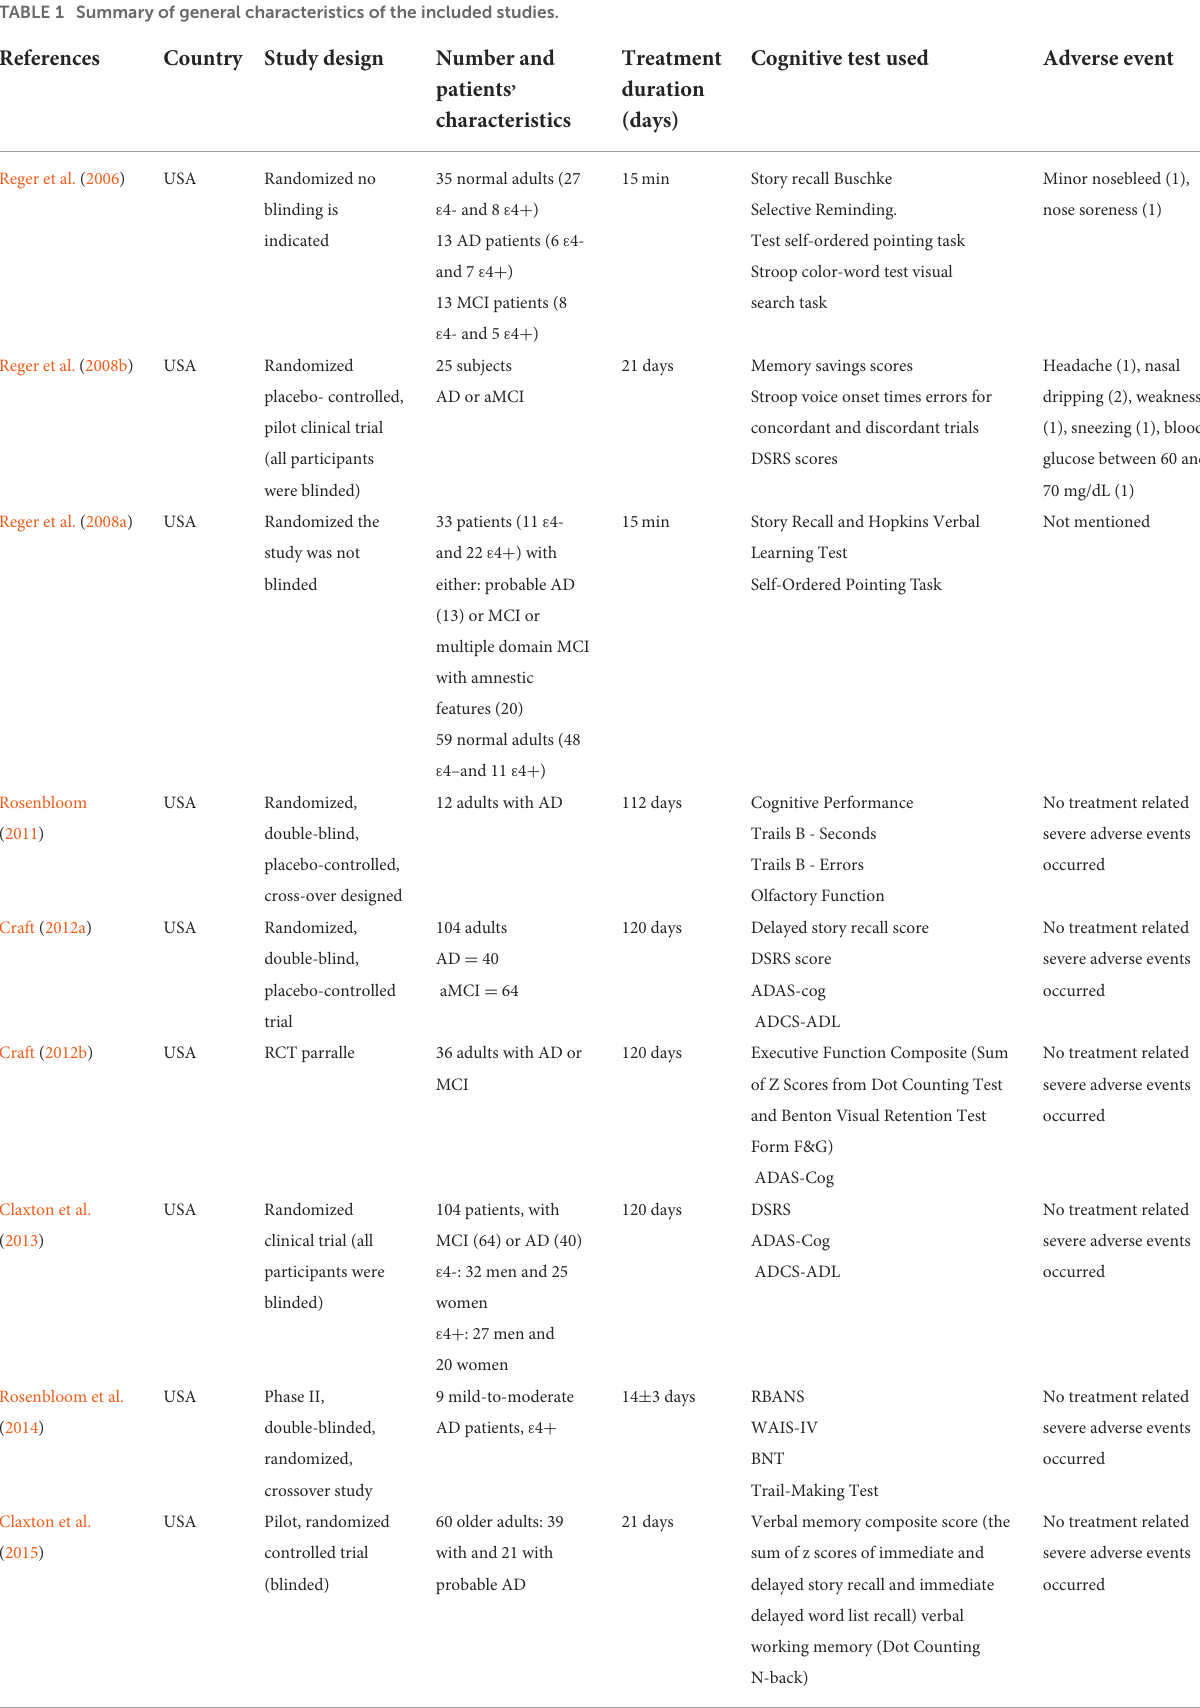
TABLE 1 Summary of general characteristics of the included